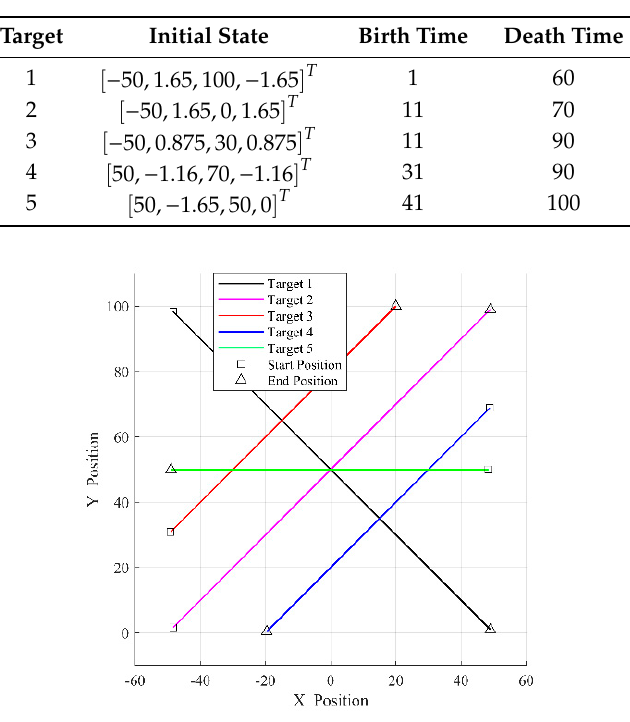
Figure 2. Simulation scenery in x-y coordinate system.